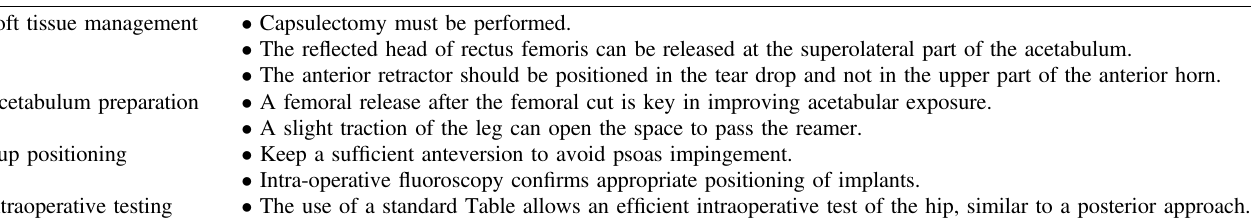
Table 4. Tips and tricks for anterior approach Soft tissue